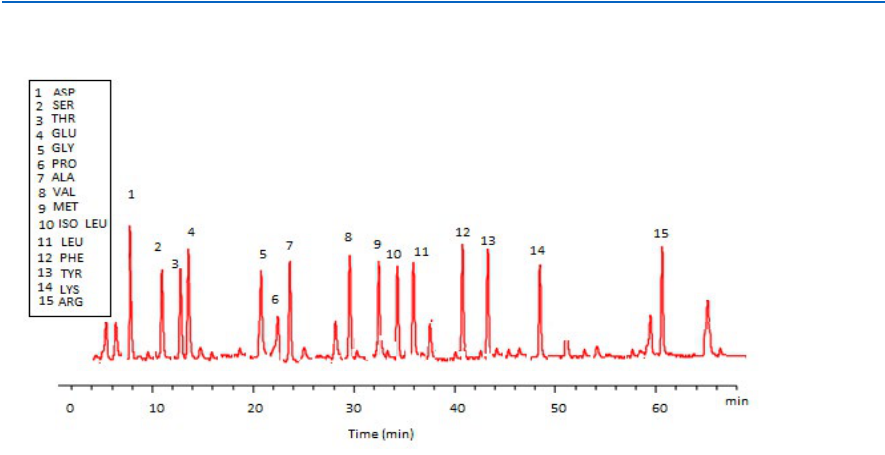
Fig. 17. HPLC analysis of total protein content of Trichoderma viride